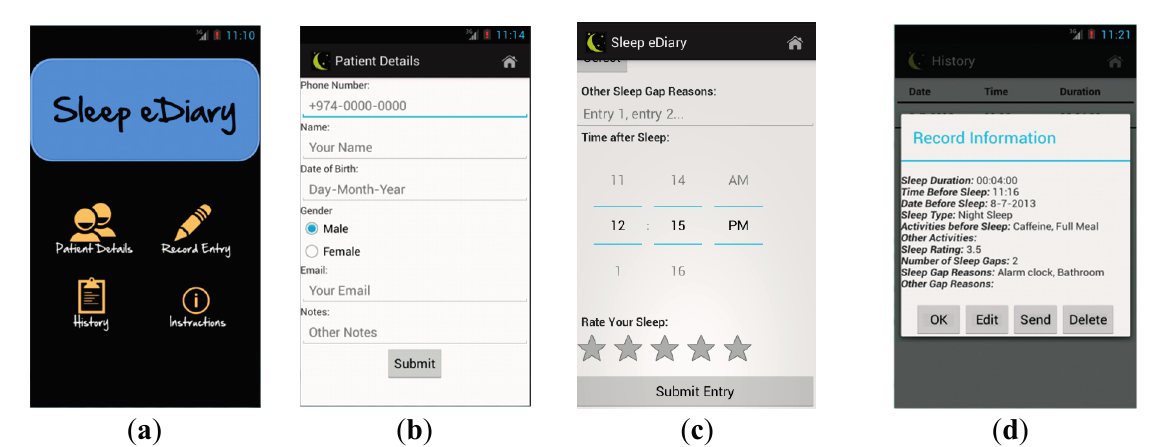
Figure 4. Electronic sleep diary architecture.